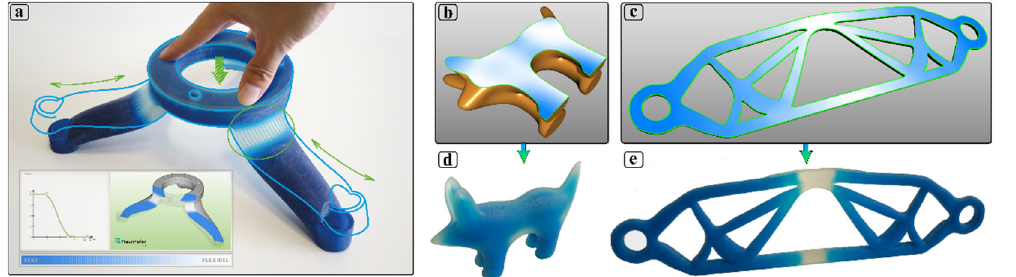
Figure 13. CAD models can be augmented with functionally graded material transitions (e.g., from stiff to flexible): ( a ) The stand produced by multi-material 3D printing damps and cushions components mounted to it, reproduced with permission [104], ( b , c ) cut through models, e.g., cayote and topology optimized model, respectively (green lines are slicing contours), ( d , e ) fabricated objects with gradient material interfaces based on volumetric models, all images are reproduced with permission, Copyright © 2019 [105].